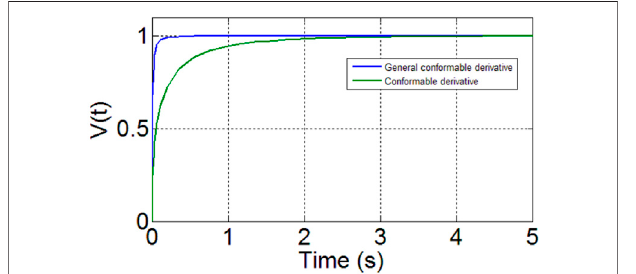
FIGURE 4 | Evolution of V ( t ) with α (cid:2) 0 . 5.